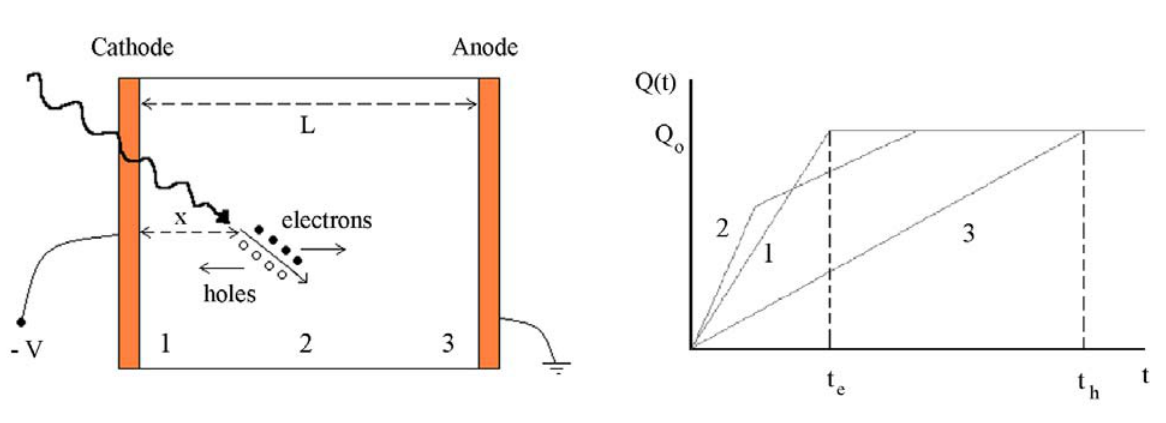
Figure 2. Planar configuration of a semiconductor detector (left). Electron–hole pairs, generated by radiation, are swept towards the appropriate electrode by the electric field. (right) The time dependence of the induced charge for three different interaction sites in the detector (positions 1, 2 and 3). The fast rising part is due to the electron component, while the slower component is due to the